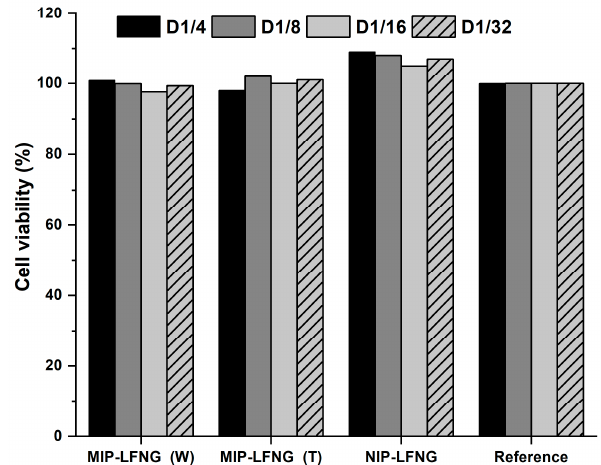
Figure 6. Cell viability of L929 cell line after 24 h exposure to various dilutions of LFNGs compared to a reference (100% viability).